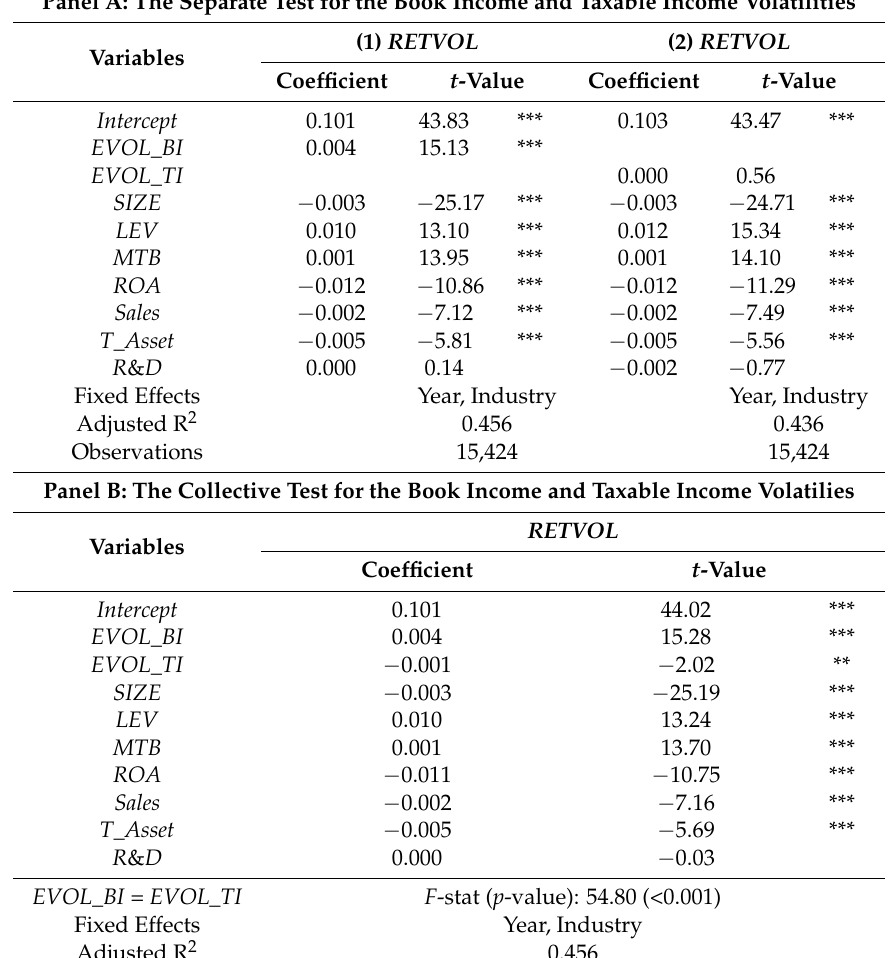
Table 4. The relevance of earnings volatilities to stock return variability. Panel A: The Separate Test for the Book Income and Taxable Income Volatilities